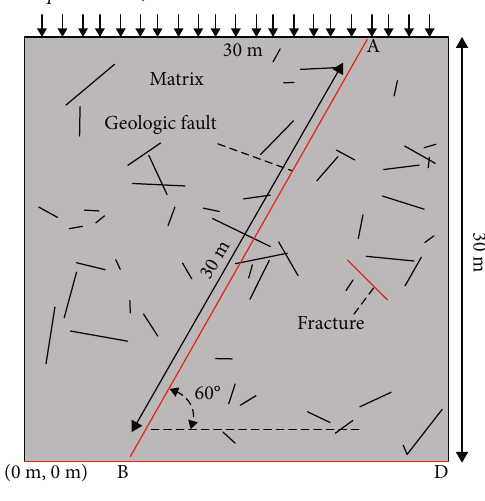
Figure 8: Geometry of the MFF model.